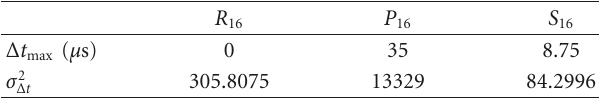
Table 2: Asymptotic results for the SO-DCTS algorithm in struc- tured networks with Gaussian